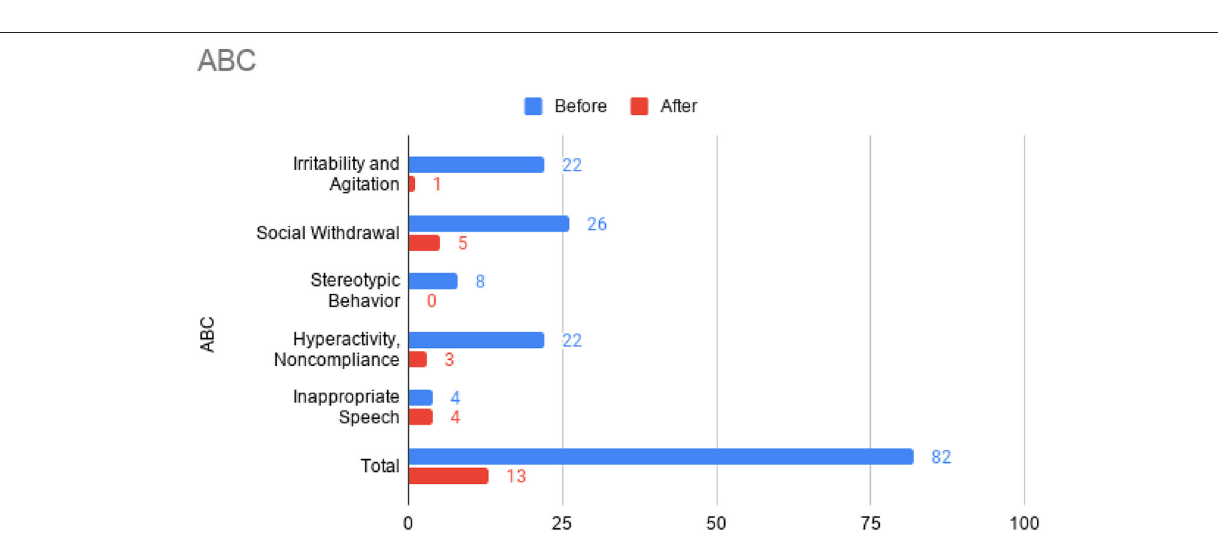
FIGURE 3 | Aberrant Behavior Checklist (ABC) sub-scores prior to the initiation of omalizumab (blue) and after the 6 month treatment period